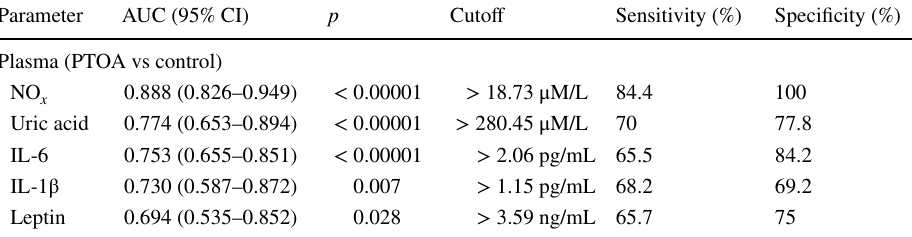
Table 4 ROC curve characteristics: circulating proinflammatory mediators as potential biomarkers of PTOA